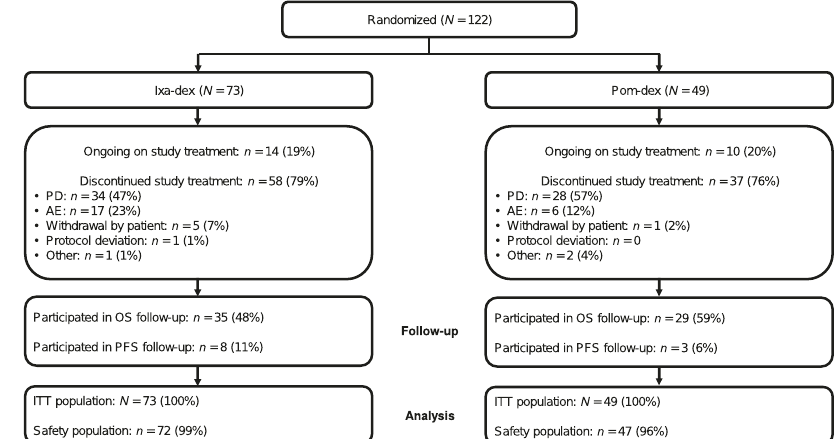
Fig. 1 CONSORT diagram. Patient disposition throughout the study. AE adverse event, dex dexamethasone, ITT intent-to-treat, ixa ixazomib, OS overall survival, PD progressive disease, PFS progression-free survival, pom